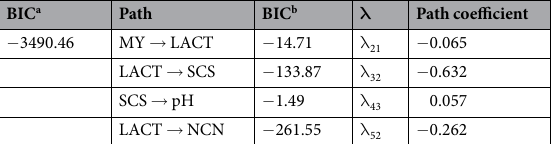
Table 2. Bayesian Information Criterion (BIC) score for the Hill-Climbing (HC) algorithm and path coefficients derived from the structural equation models. a Bayesian information criterion score (BIC) for the entire network. b BIC scores for pairs of nodes; the change in the score when removing the arc relative to the entire network score is showed. MY: milk yield; LACT: lactose percentage; pH: milk pH; SCS: somatic cell score; NCN: non-casein N(expressed as % of total milk N).